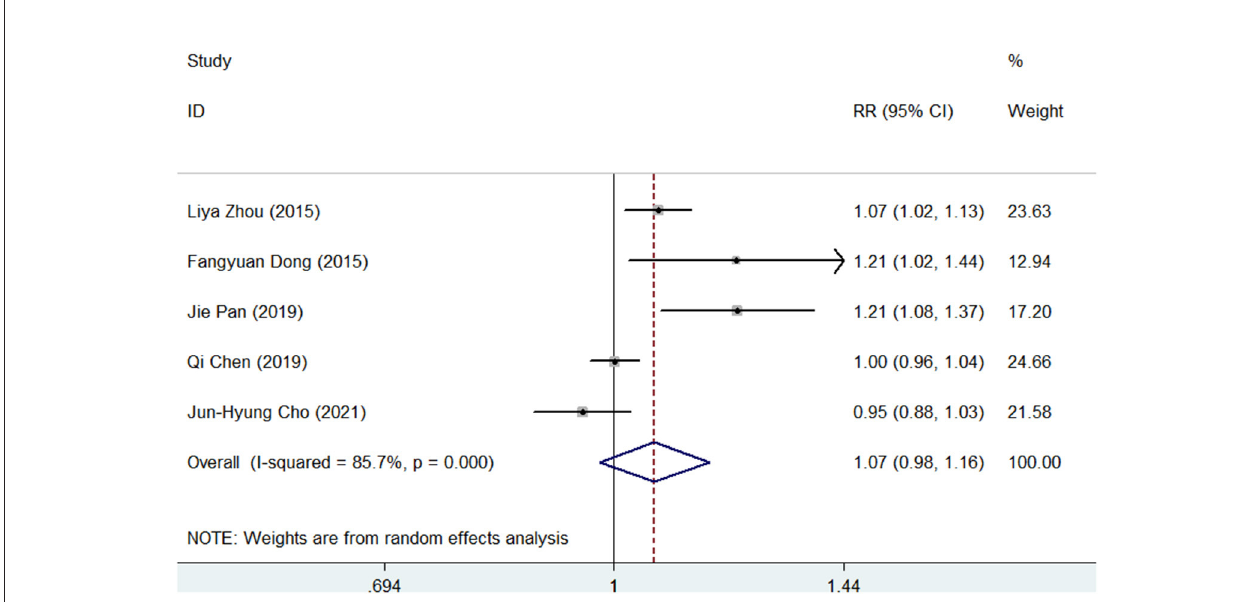
FIGURE 4 | Forest plots for the comparison of SGT vs. BQT using the different types of antimicrobial susceptibility tests in H. pylori eradication.